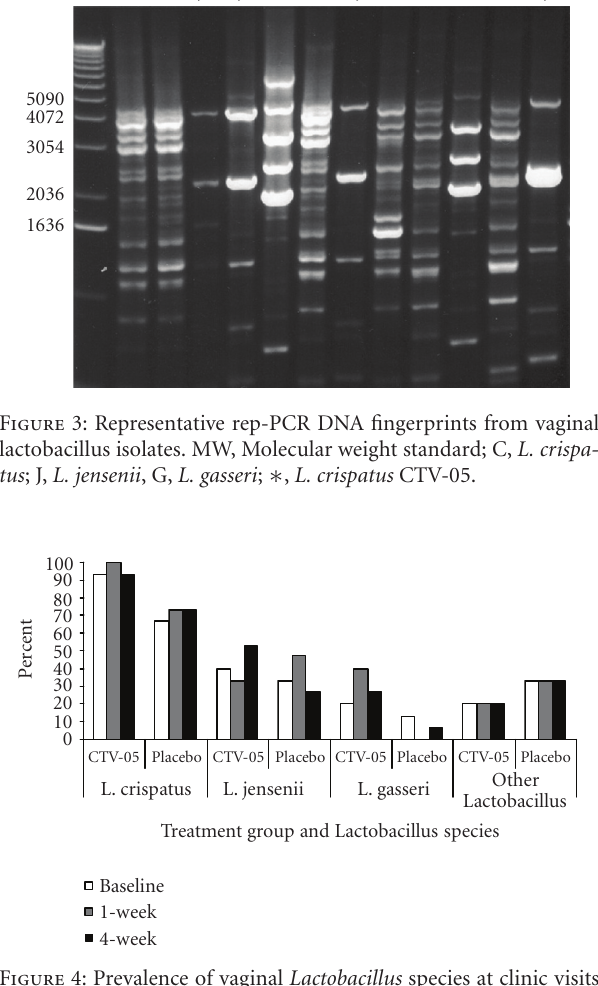
Figure 4: Prevalence of vaginal Lactobacillus species at clinic visits ( N = 15 for each treatment group. P > . 05 for comparison of L. crispatus CTV-05 to placebo at all visits except for L. gasseri at 1- week ( P = . 02)). CTV-05, L. crispatus